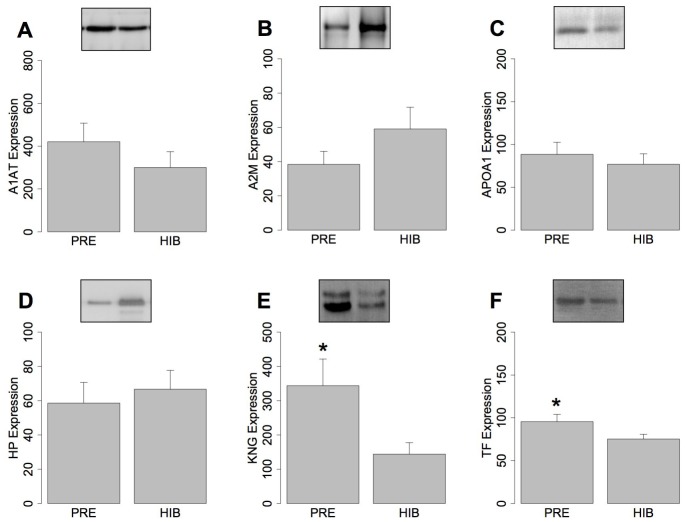
Specific proteins expression in bear serum.Western immunoblots and histograms of the mean + standard error of the mean (n = 8) protein expression (arbitrary units as a proportion of pooled reference black bear serum) between pre-hibernating (“Pre”) and hibernating (“Hib”) black bears using antibodies against A) α1-antitrypsin (A1AT), B) α2-macroglobulin (A2M), C) apolipoprotein A1 (ApoA1), D) haptoglobin (Hp), E) kininogen 1 (KNG), and F) transferrin (Tf). Changes in protein expression between hibernation states of individual bears are overlaid on top of the histogram. A representative western blot is shown inset, and the left and right wells are loaded with pre-hibernation and hibernation serum samples, respectively. Statistically significant differences (p<0.05, paired 1-way ANOVA) between hibernation states are indicated with asterisks. A2M was significant at p = 0.07.